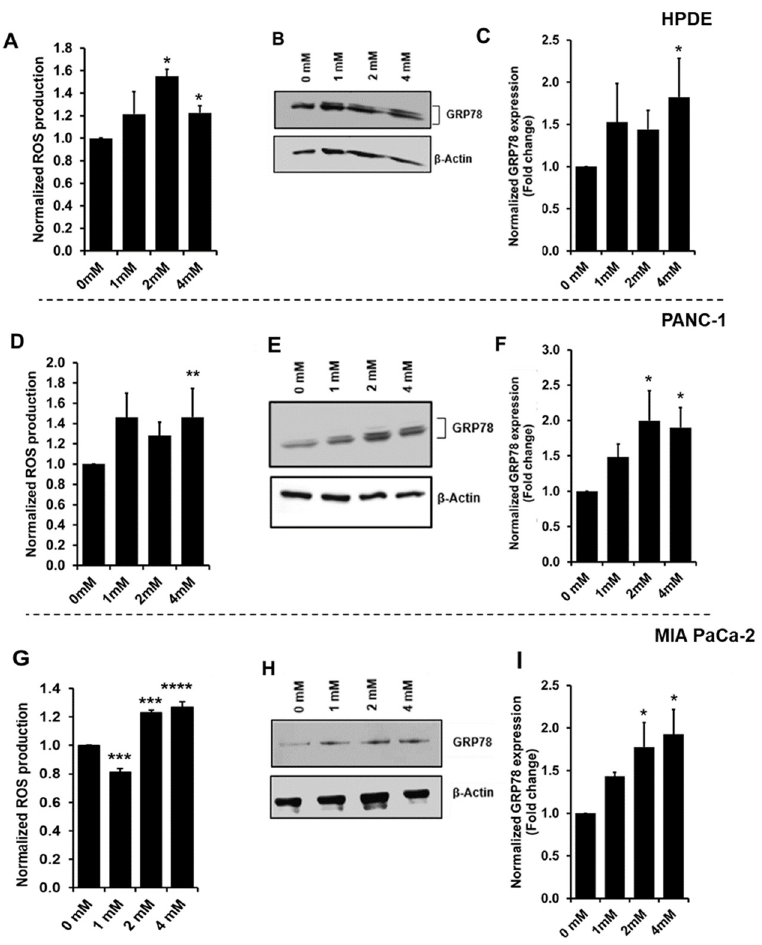
Figure 2. Oxidative Stress in HPDE, PANC-1, and MIA PaCa-2 cells treated with glyceraldehyde for 48 h. ( A , D , G ) ROS production determined as fluorescence of 2 (cid:48) , 7 (cid:48) -dichlorofluorescin (DCF) production. Data were normalized to cell viability. ( B , E , H ) Western blot for GRP78 expression in cells treated with glyceraldehyde. ( C , F , I ) Quantitative analysis of GRP78 expression in cells treated with glyceraldehyde. Data were normalized to control (0 µ M). Data represent the mean ( n = 3) ± SE. **** p < 0.0001, *** p < 0.001, ** p < 0.01, * p < 0.05 vs. control (0